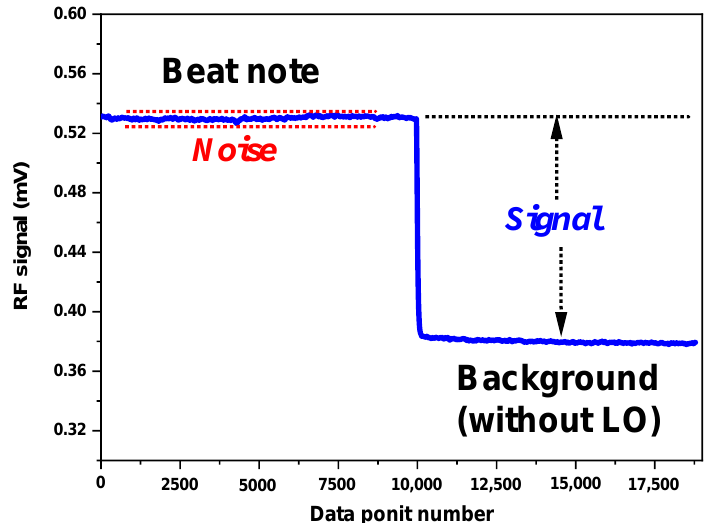
Figure 2. SNR measurement of the beat note at the output of the LIA. The theoretical shot-noise-limited SNR of the LHR can be expressed by Equation (1) [22–24]. This equation can be used to assess the experimental LHR performance when referenced to the ideal shot-noise limit. In other words, it corresponds to the expected performance of an ideal LHR in which shot noise is the sole noise [25]: